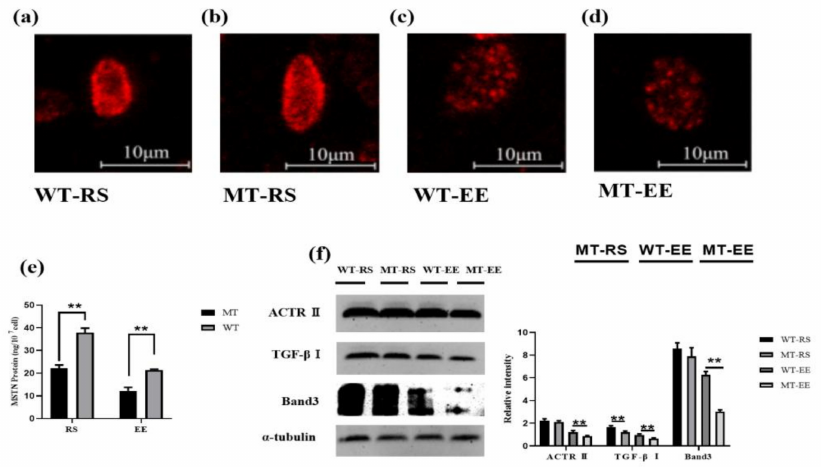
Figure 7. MSTN knockout affected the Band3 protein in the erythrocyte membrane. ( a ) The Band3 protein in the WT-RS group erythrocytes; ( b ) the Band3 protein in the MT-RS group erythrocytes; ( c ) the Band3 protein in the WT-EE group erythrocytes; ( d ) the Band3 protein in the MT-EE group erythrocytes; ( e ) MSTN protein content; ( f ) Western blotting results. MT: MSTN knockout cattle group; WT: Wild type cattle group; RS: Resting state; EE: Exhaustive exercise state; Data presented are means ± SD. One-way ANOVA with post hoc LSD multiple-comparison test. ** p <